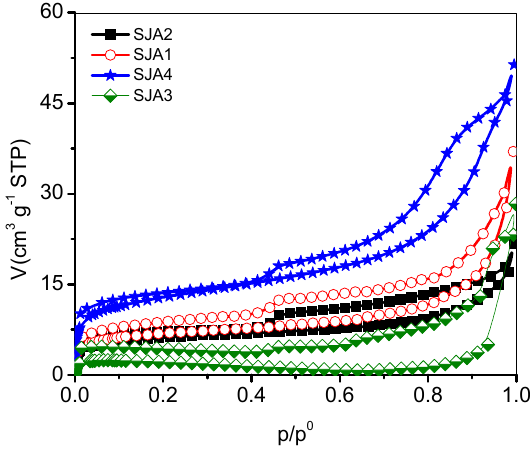
Figure 2. N 2 adsorption isotherms of soil samples from San Juan Amecac, Puebla, México.